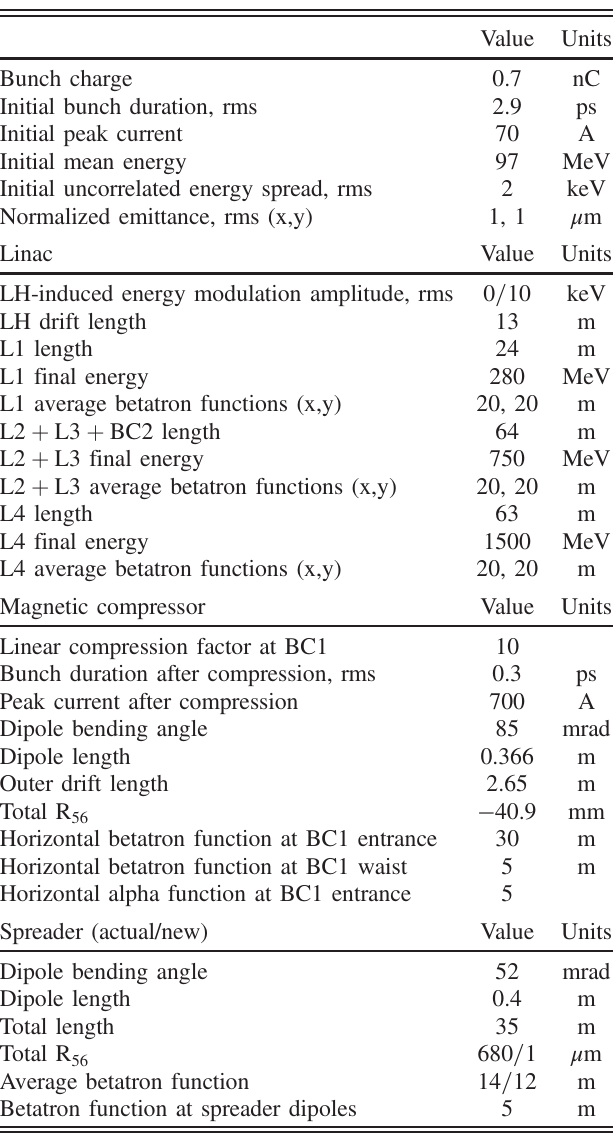
TABLE I. FERMI FEL-2 parameters adopted for the MBI study. The initial charge distribution is assumed to be flattop, and the bunch length compression in BC1 is a linear process (current shape is preserved). See Fig. 1 for naming of the individual linac